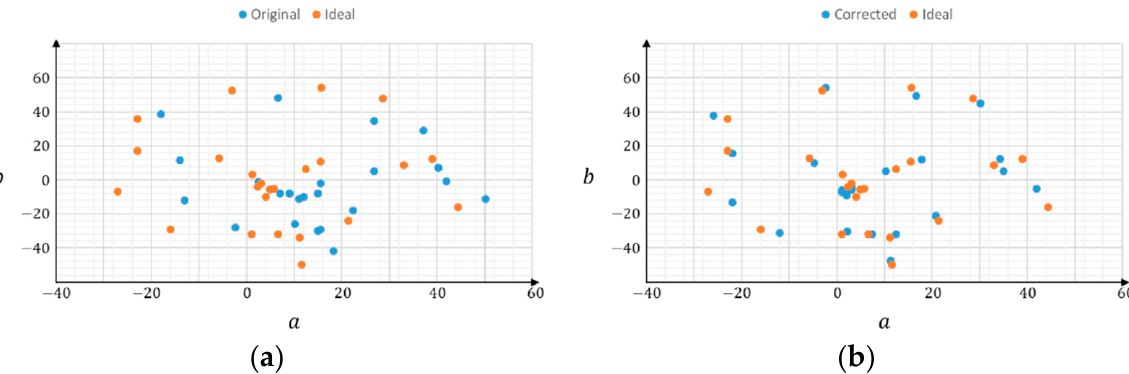
Figure 14. The distribution of 24 colors in 𝑎𝑏 plane: ( a ) original vs. ideal, and ( b ) corrected vs. ideal colors.